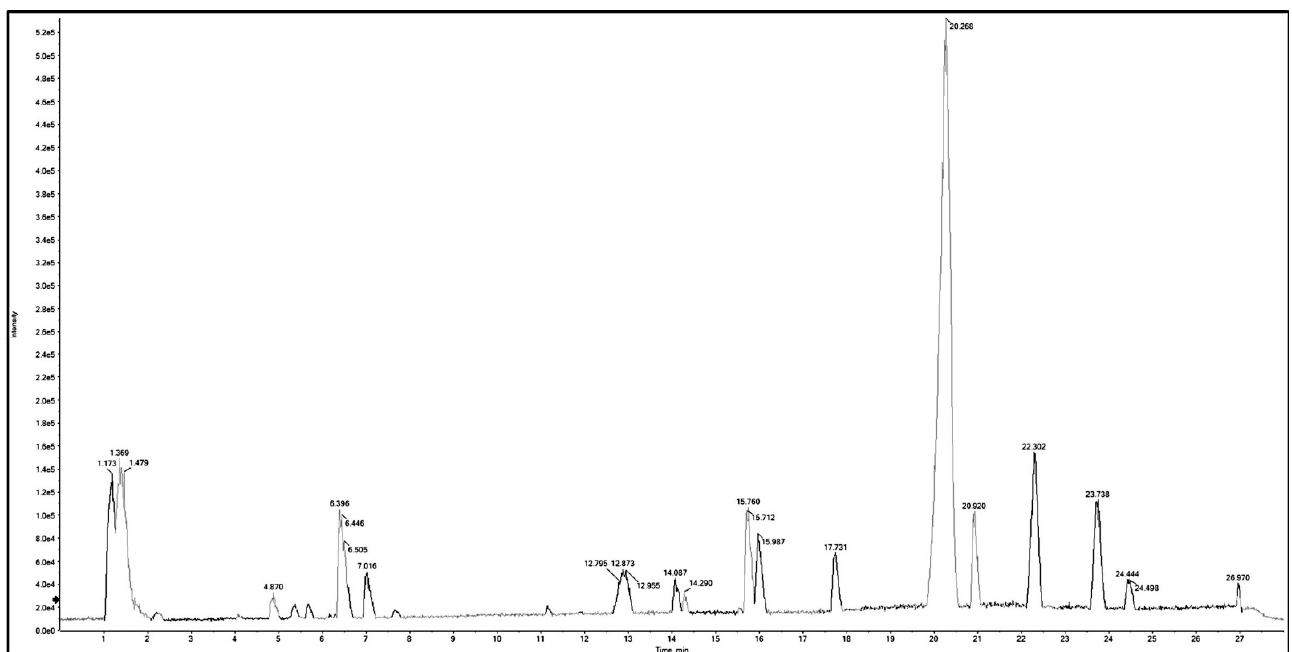
Figure 1. Base peak chromatogram (BPC) of Q-TOF LC/MS/MS analysis of B. armeniaca methanolic extract (BME) in positive mode.